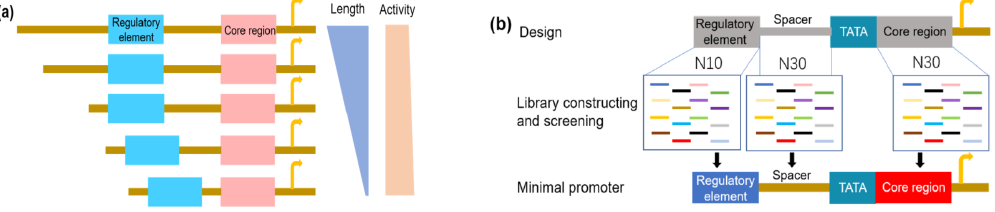
Figure 4. Methods for minimal promoter construction. ( a ) Rational truncation of endogenous promoters; ( b ) Artificial construction de novo by constructing and screening the promoter library. N30 and N10 mean the random mutation libraries of 30 and 10 consensus nucleotides, respectively.